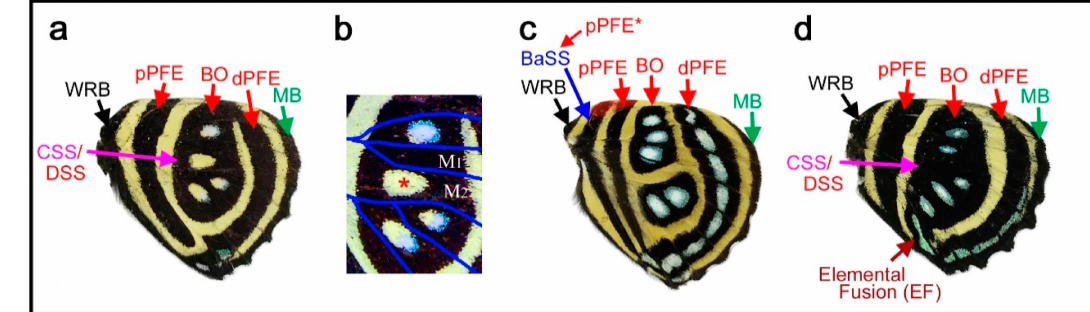
Figure 7. Three Callicore species with various patterns of the potential DS area. ( a ) Callicore hydaspes . ( b ) The discal area of the wing shown in a. An asterisk indicates the location of the potential discal spot. The compartments M 1 and M 2 (assuming the presence of the discalis cross vein) are indicated. ( c ) Callicore pygas . An alternative identification is shown as pPFE*. ( d ) Callicore lyca